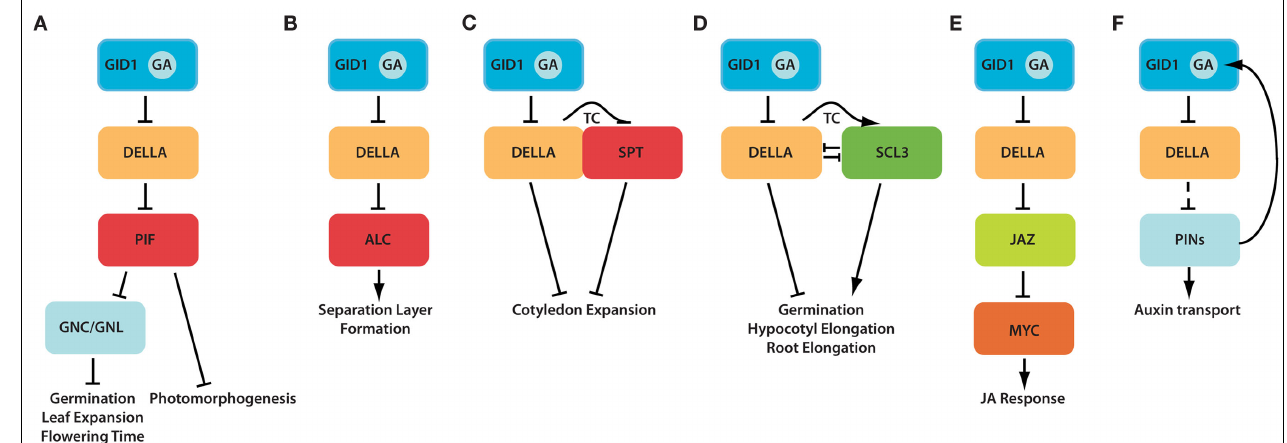
FIGURE 2 | Different molecular modes of action of DELLA repressors. (A) GID1 induces DELLA inactivation by promoting DELLA degradation in response to hormone binding. DELLAs repress the DNA-binding activity of PIFs, which are also negatively regulated by light. GNC and CGA1/GNL are two important targets downstream from GA signaling, DELLAs, and PIFs. GNC and CGA1/GNL repress major but not all aspects of GA signaling. (B) DELLAs also repress the PIF-related protein ALC. Separation layer formation is dependent on the relief of DELLA repression on ALC and this is mediated by the induction of GA biosynthesis gene expression by the ALC upstream regulator IND. (C) SPT is closely related to ALC and PIFs but appears to be regulated by DELLAs in a differential manner from PIFs. The current hypothesis predicts that SPT and DELLAs interact and